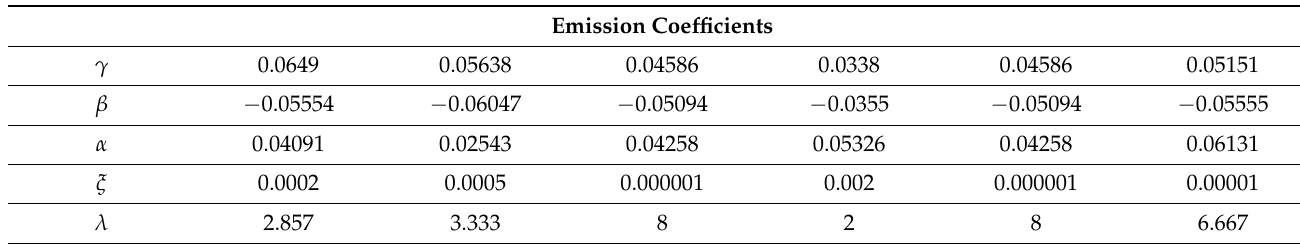
Table A3. Emission coefficients of generators for the IEEE 30-bus power system for Case